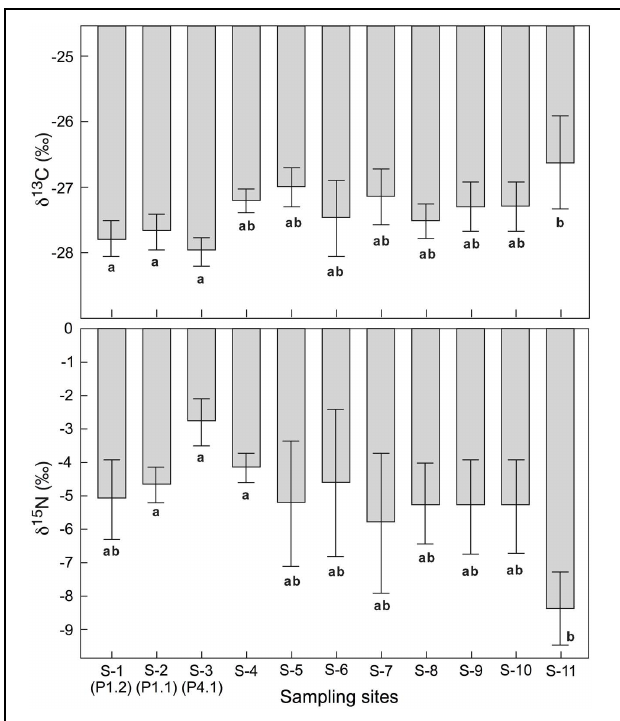
FIGURE 4 | Means of foliar δ 13 C and δ 15 N for four co-occurring alpine plant species in all 11 sites (mean ± SE). There was no overall site effect across all sites. But means for some individual sites differed (different letters indicate significant differences at p <